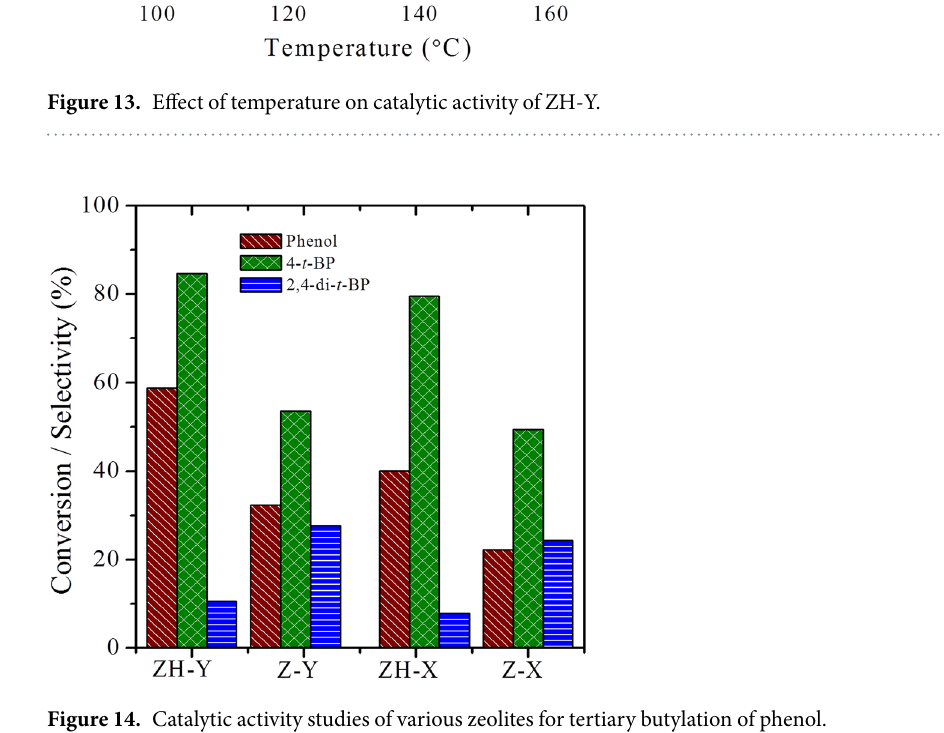
Figure 14. Catalytic activity studies of various zeolites for tertiary butylation of